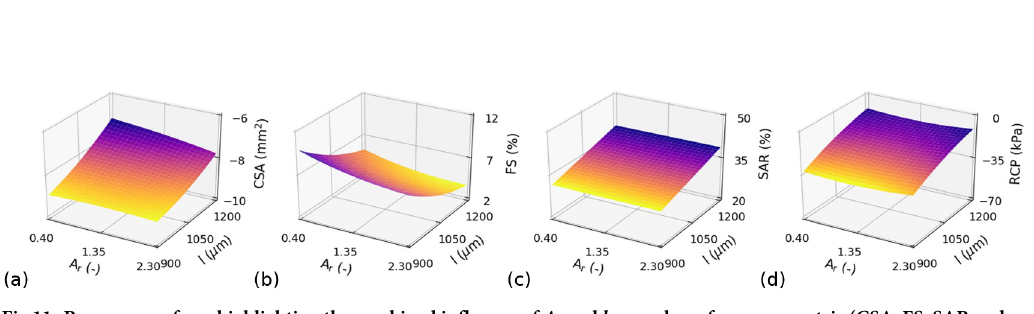
and l on each performance metric (CSA, FS, SAR and r